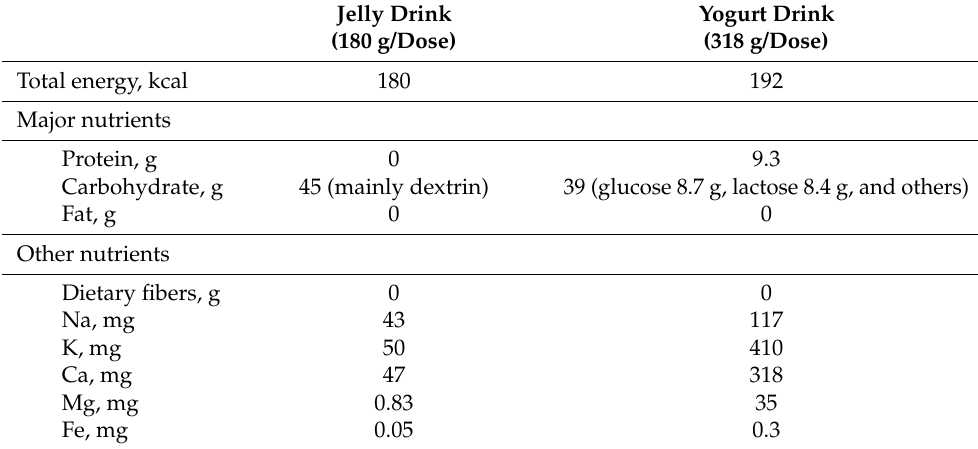
Table 4. The composition of